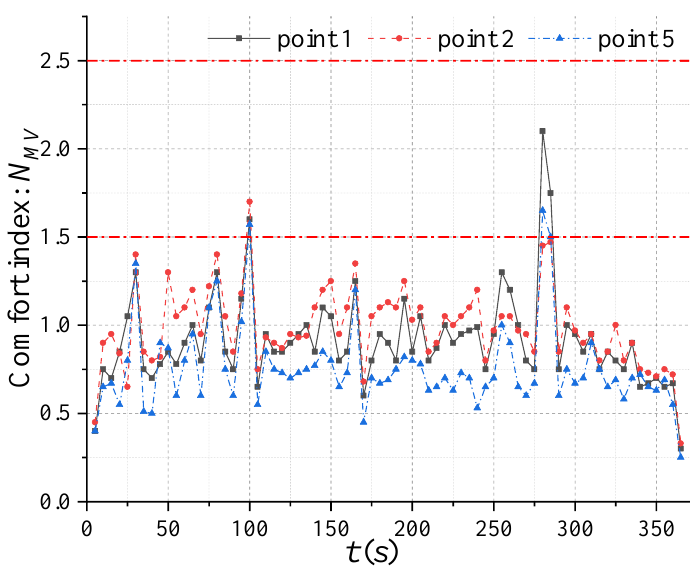
Figure 6. Stability index under full load operation.